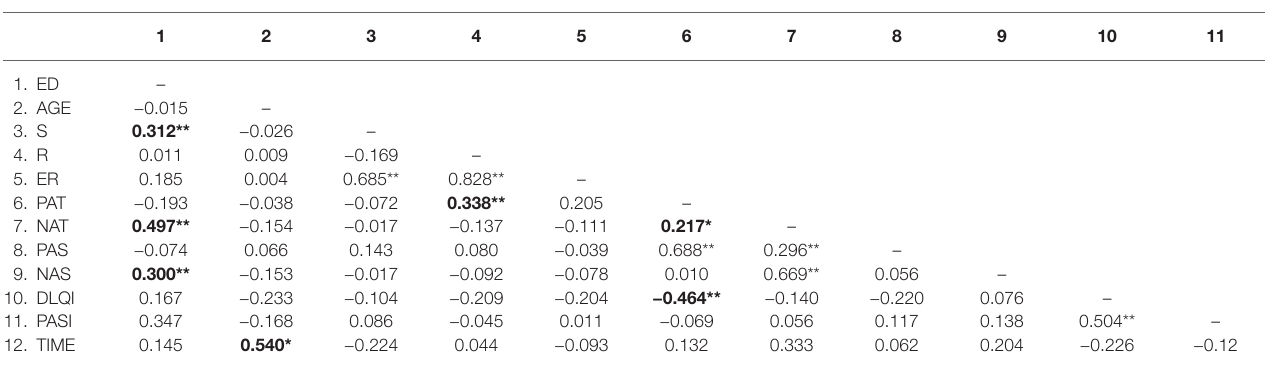
TABLE 4 | Correlations between variables in psoriasis group: S (expressive suppression), R (cognitive reappraisal), ER (emotion regulation measured as total score of ERQ), PAT (positive affect of trait), NAT (negative affect of trait), PAS (positive affect of state), NAS (negative affect of state), ED (emotion regulation measured as total score of DERS), AGE, TIME (illness length), PASI (disease severity), and DLQI (quality of life). The relevant values are presented in bold